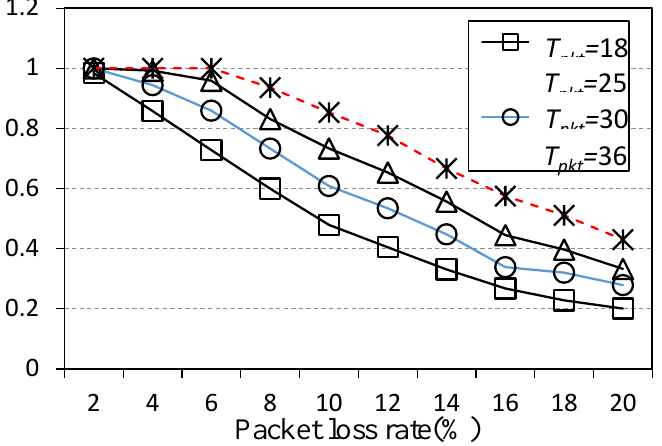
Figure 8. V ariations of R avg according to the total number of FEC packets ( T pkt ) in different packet loss rates.